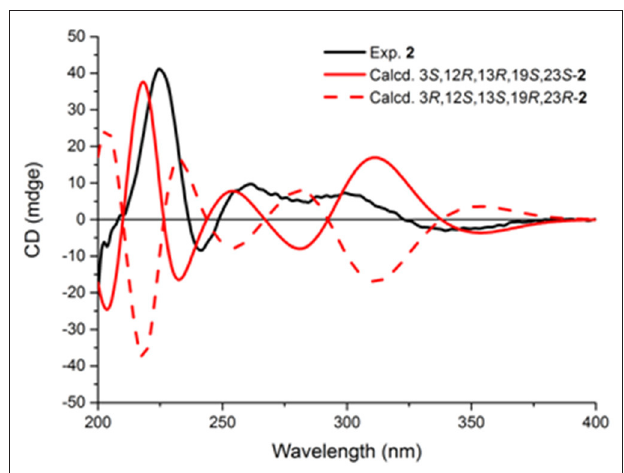
FIGURE 6 | Experimental and calculated ECD spectra of compound 2 .